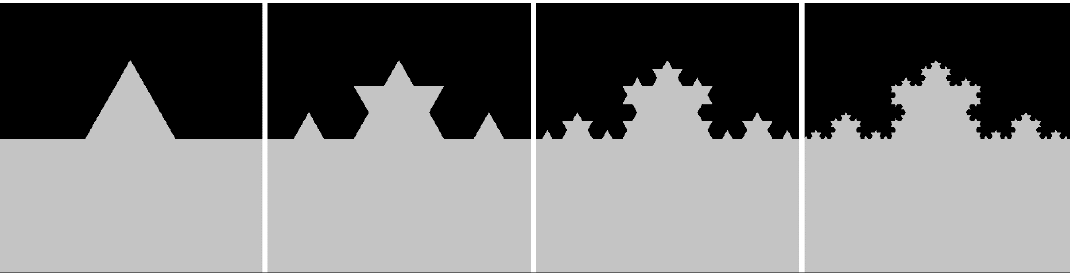
Figure 5. Koch curve, iteration steps 1–4 (from left to right).